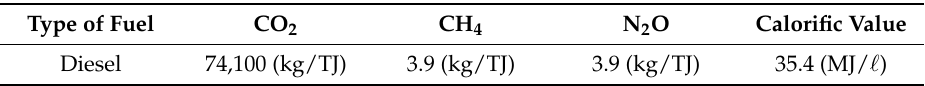
Table 6. Net calorific value of diesel ( EC i ) and GHG emission factors ( EF ij ) derived from the ”Guideline for the operation of management by objectives concerning GHG and energy (Ministry of Environment Document No. 2013-180)”